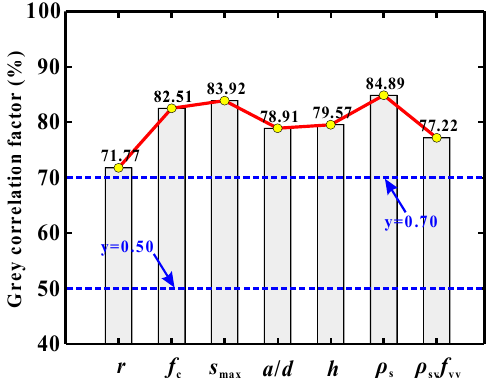
Figure 2. Parametric importance evaluated by Grey relational analysis (GRA).